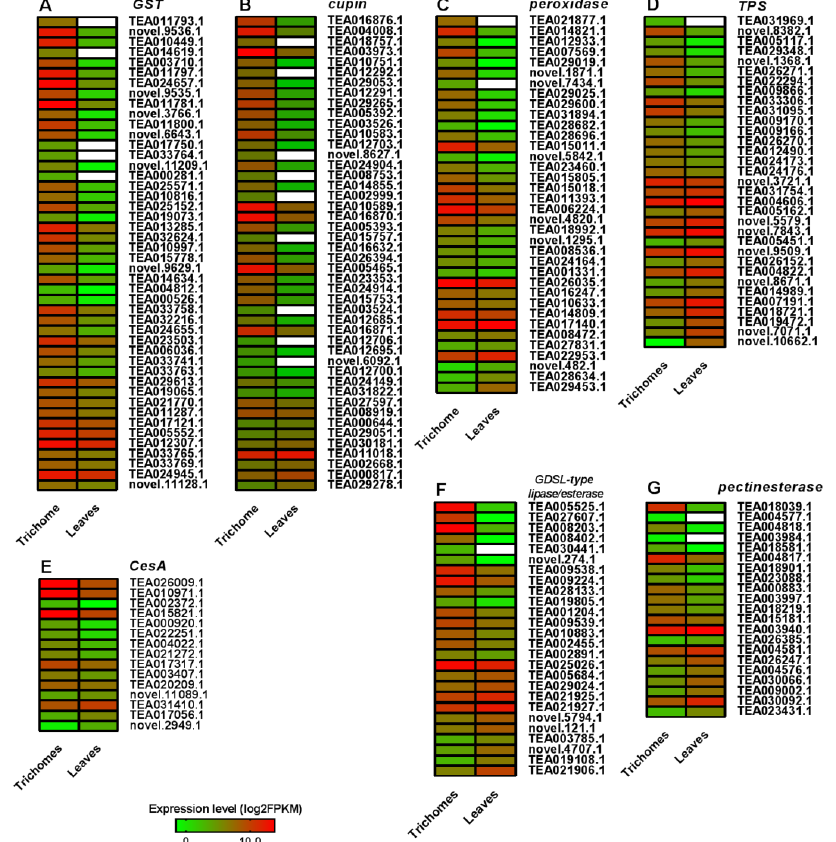
Figure 5. Expression patterns of other key DEGs in the comparison of trichomes vs. leaves. The significantly expressed transcripts (log 2 FoldChange > 1.0) of glutathione S-transferase ( GST , A ), cupin superfamily proteins ( cupin , B ), pectinesterase ( C ), terpene synthase ( TPS , D ), cellulose synthase ( CesA , E ), GDSL-type lipase / esterase ( F ), and peroxidase ( G ) were identified, and their expression levels in the trichomes and tea leaves are represented by heat maps. The transcripts that were not detected with FPKM values are shown in white.